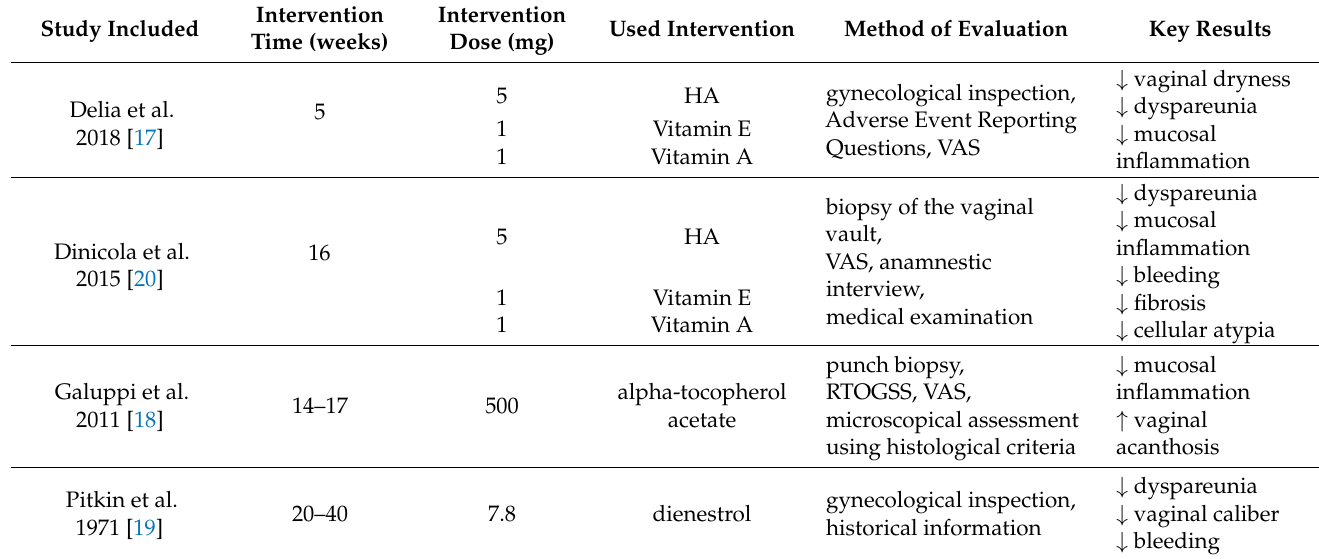
Table 2. Intervention methods—outcomes of clinical